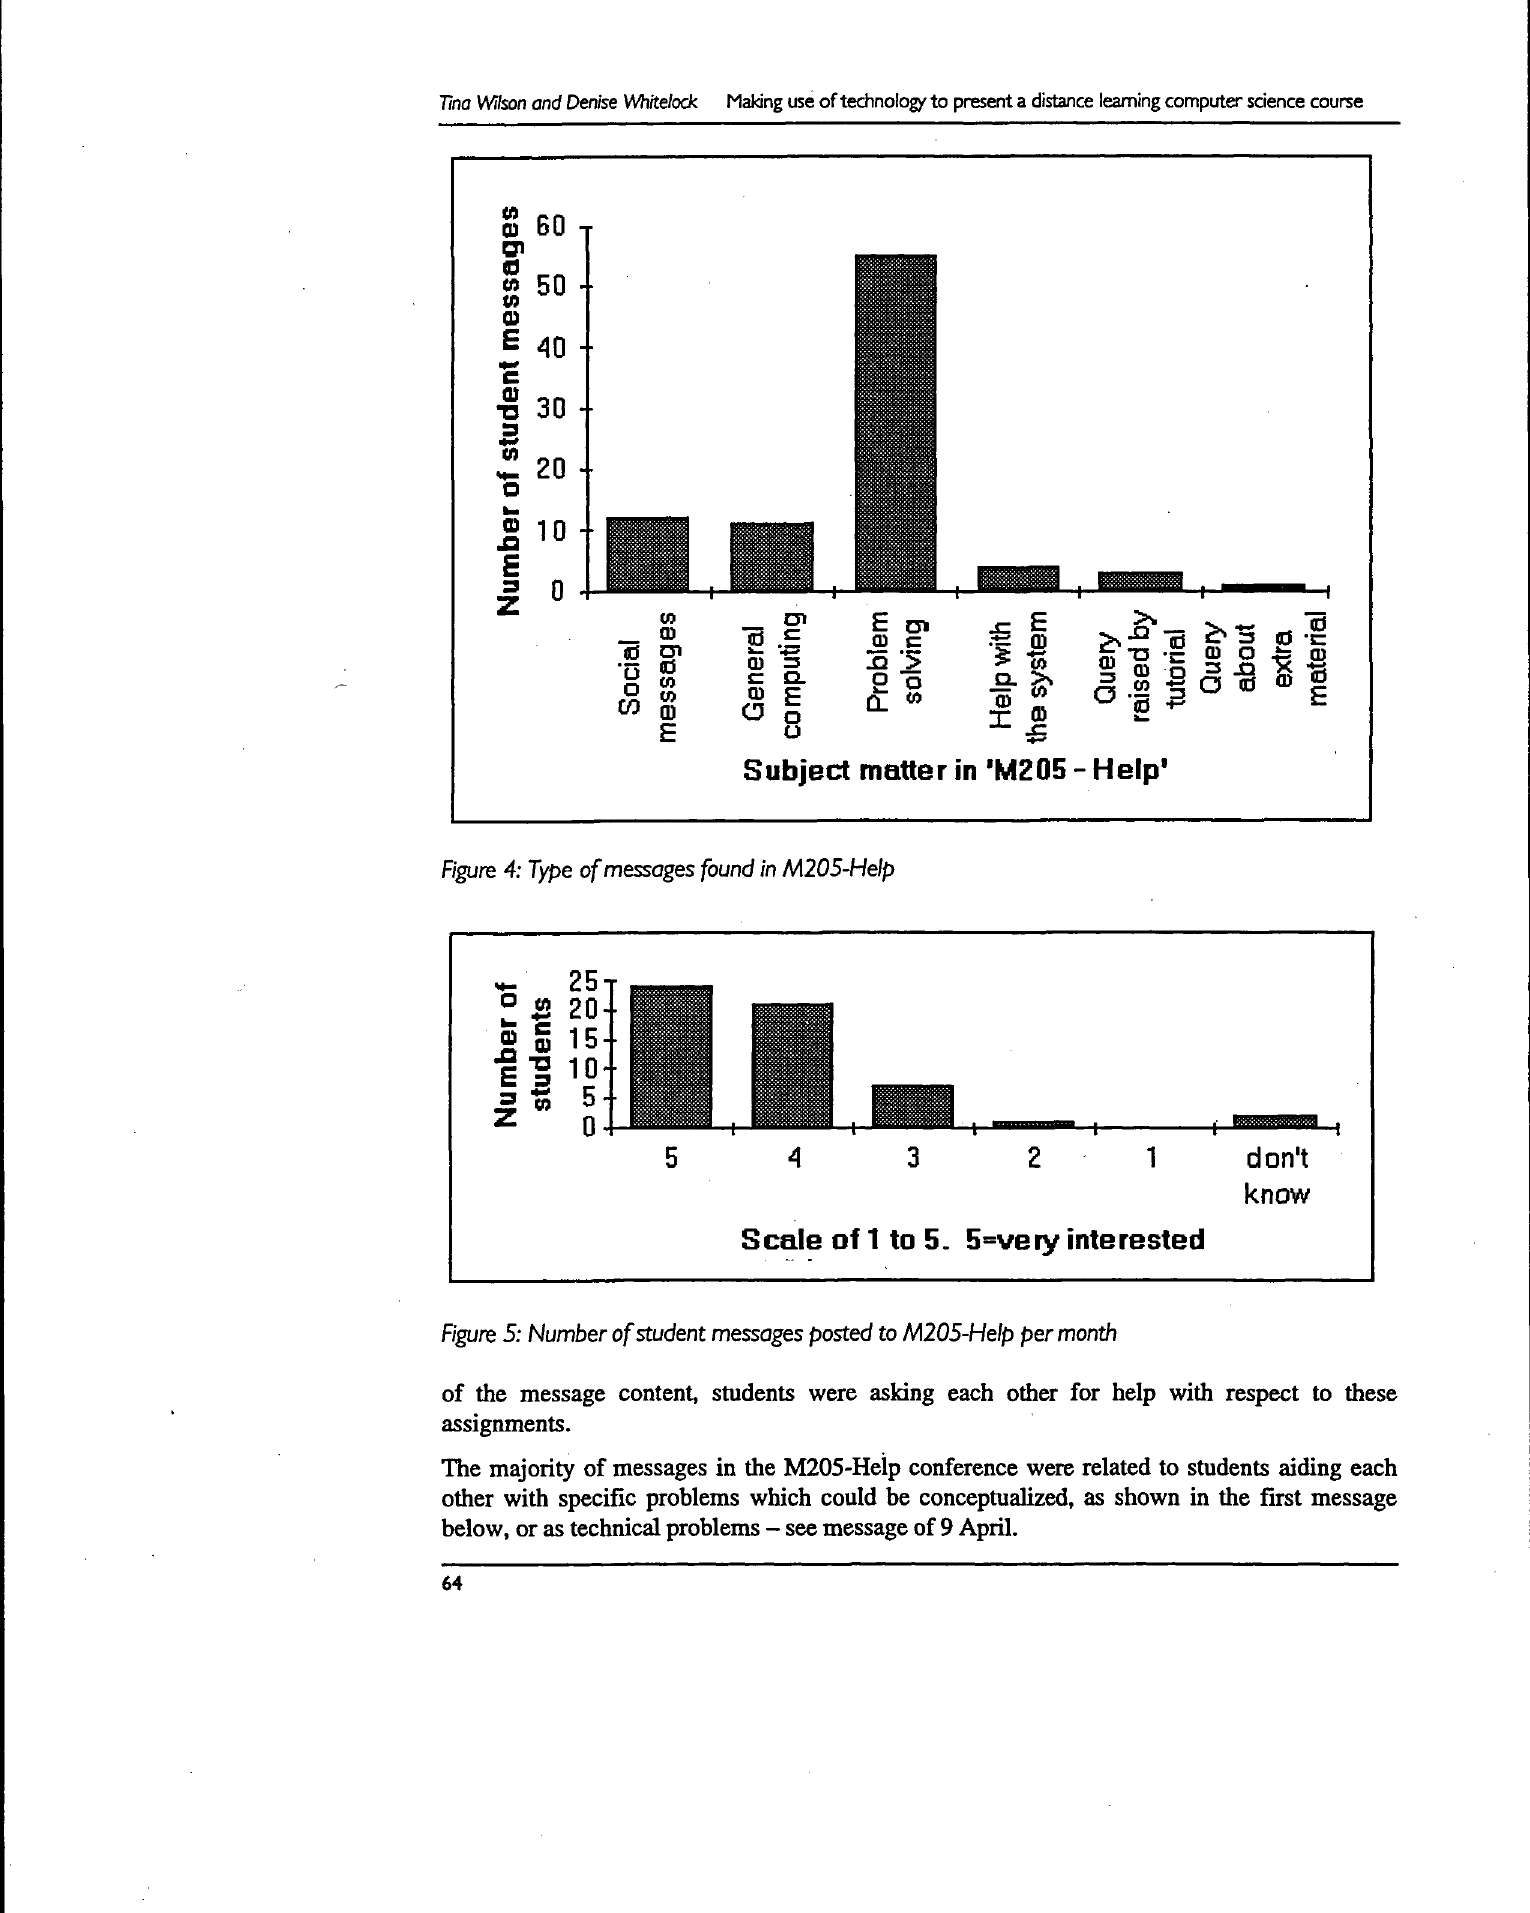
Figure 5: Number of student messages posted to M205-Help per